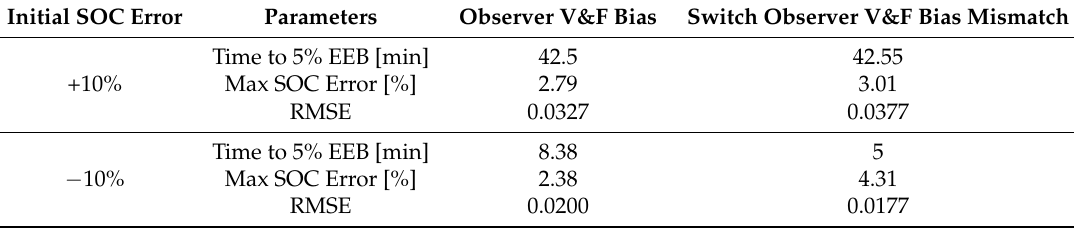
Table 5. Comparison of the RMSE index for different initial estimate error and different sensors using the simulated data with and without model mismatch. V, terminal voltage; V&F Bias, fusion of both sensors; V&F Bias Mismatch, fusion of both sensors with model